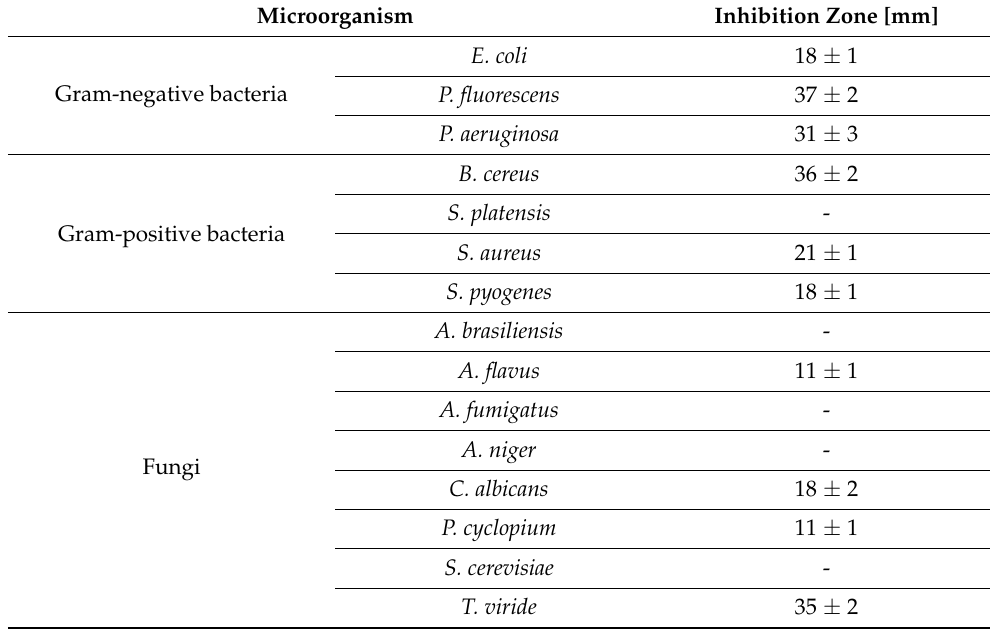
Table 4. Qualitative determination of antimicrobial activity of lyophilized PP extract obtained by supercritical fluid extraction (SFE) using CO 2 and EtOH as co-solvent at 20 MPa. Initial concentrations of bacteria and fungi were 10 5 –10 6